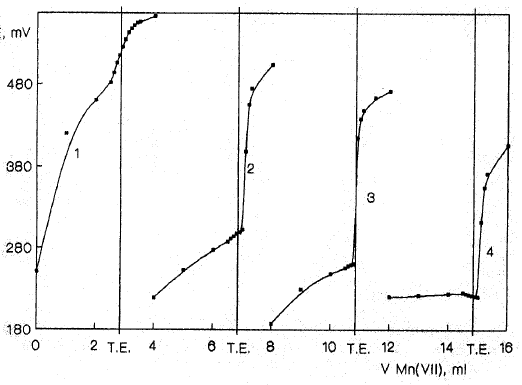
Figure 3. Potentiometric titrations of Mn(II) in pyrophosphate at various pH values (1. pH 4.00; 2. pH 5.00; 3. pH 6.00; 4. pH